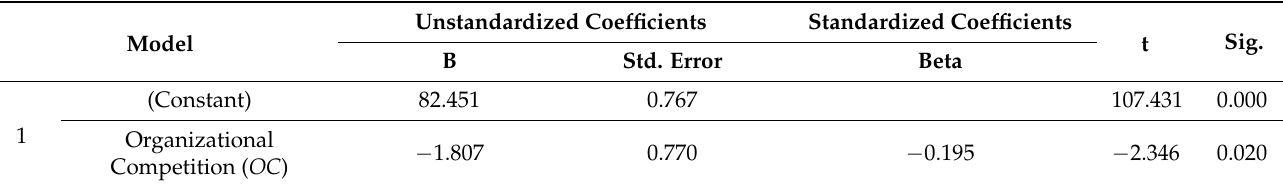
Table 9. Results of regression between OC and the effectiveness of ITG a